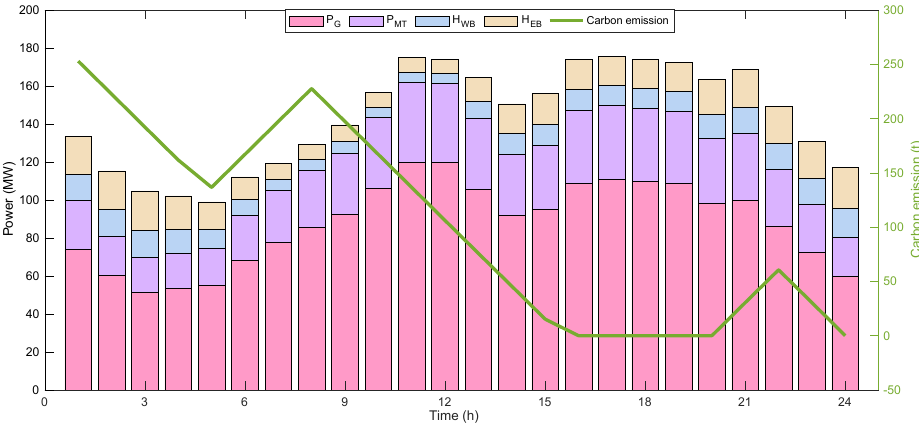
Figure 6. Power dispatch of the MEVPP system under Scenario 1.